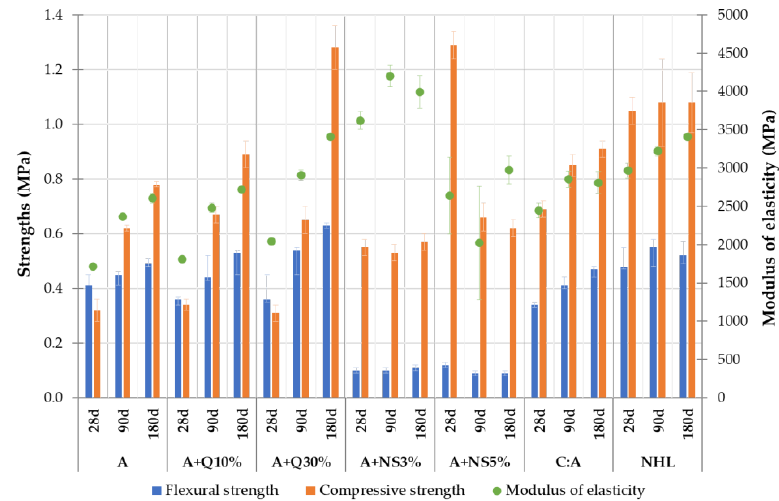
Figure 5. Mechanical properties of the mortars with siliceous sand.